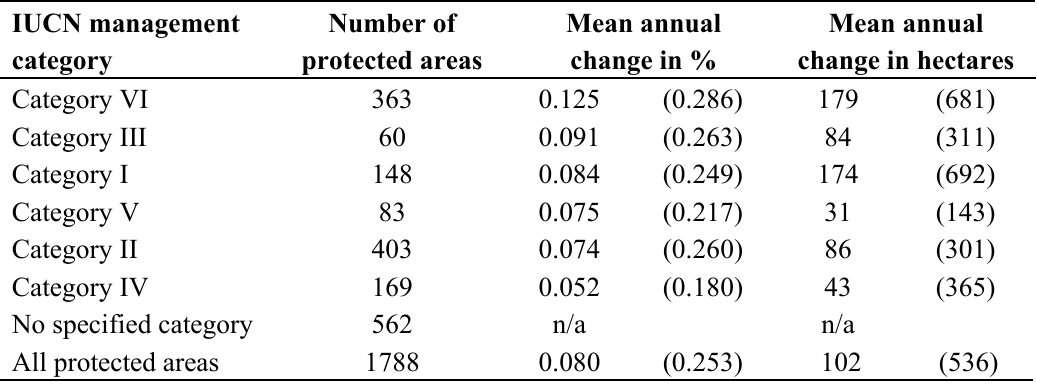
Table 5. 2004–2009 mean annual change in land and forest degradation inside protected areas by IUCN category (standard deviations in